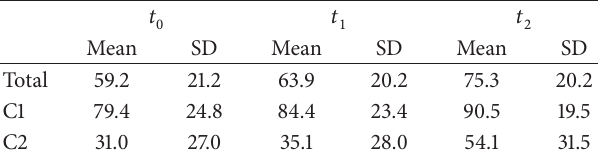
Table 1: Scale results for all patients assessed ( 𝑛 = 88 ).